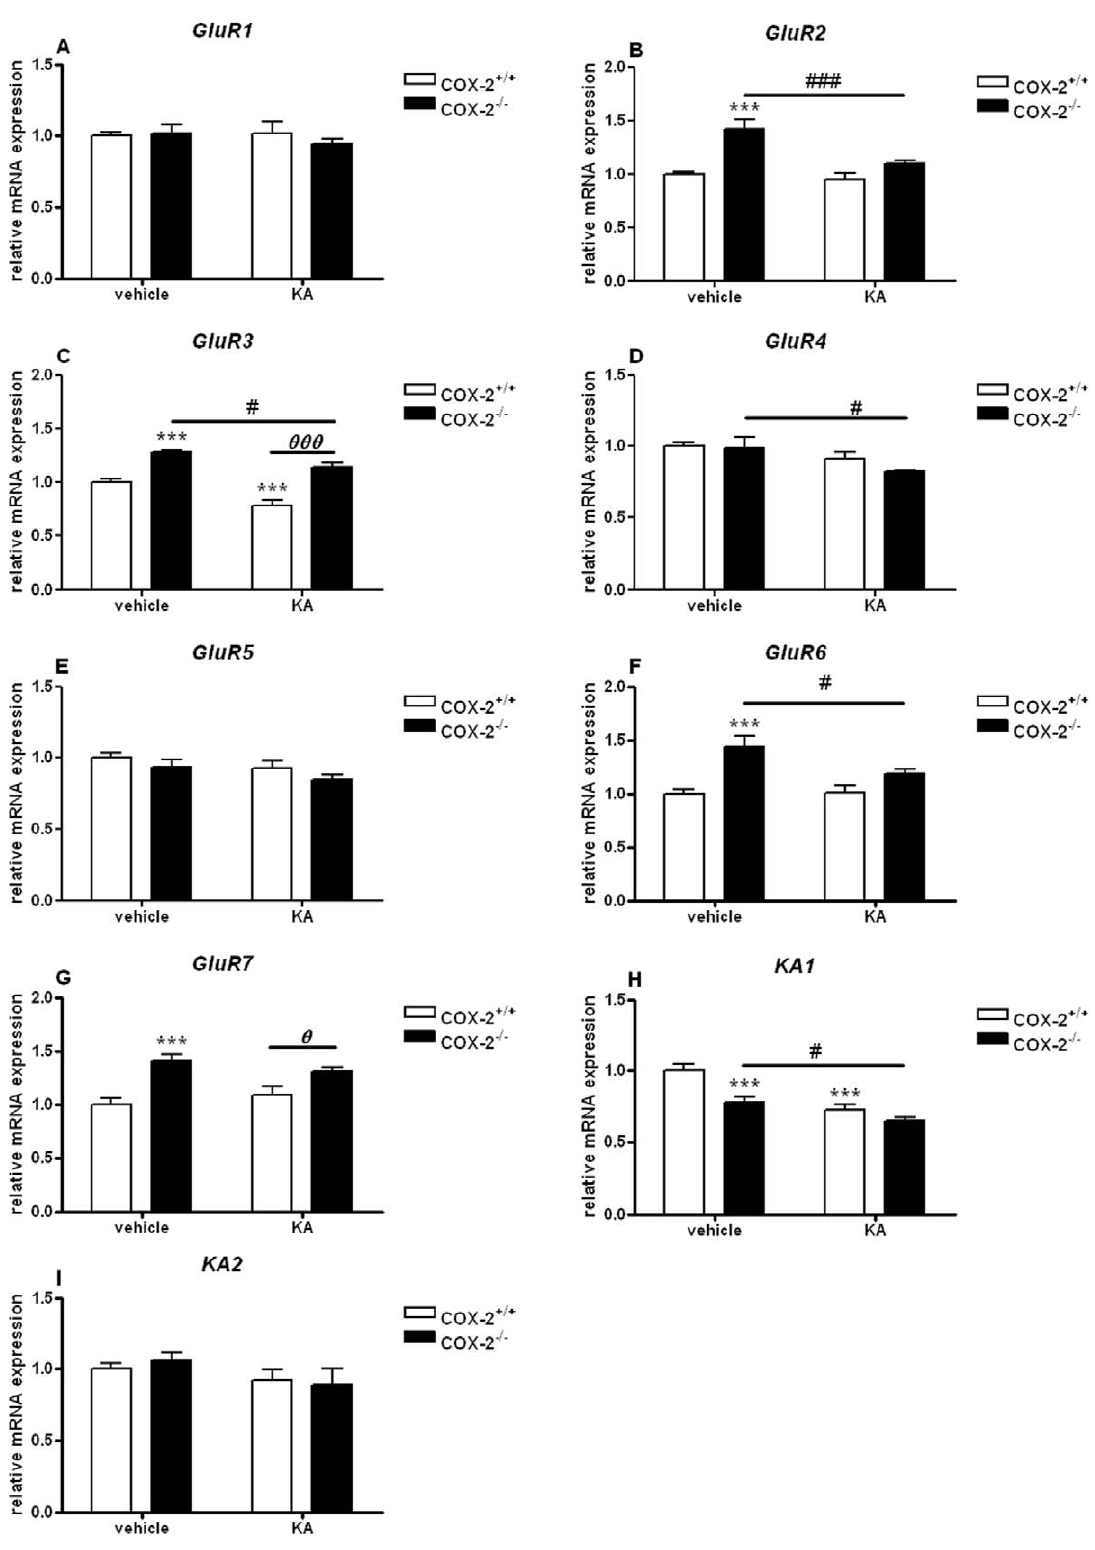
Figure 2. KA-induced expression of AMPA/KA receptor subunits in the cortex of COX-2 + / + and COX-2 2 / 2 mice. Quantitative real time- PCR analysis of GluR1 (A), GluR2 (B), GluR3 (C), GluR4 (D), GluR5 (E), GluR6 (F), GluR7 (G), KA1 (H), KA2 (I) for COX-2 + / + and COX-2 2 / 2 mice 24 h after i.p. injection of KA or vehicle. Data are means 6 SEM ( n =9). Statistical analysis was performed using a two-way ANOVA and Bonferroni’s post-hoc test to compare replicate means. *P , 0.05, **P , 0.01, *** P , 0.001 compared to vehicle-injected COX-2 + / + mice; # P , 0.05, ## P , 0.01, ### P , 0.001, compared to vehicle-injected COX-2 2 / 2 mice; fi P , 0.05, fifi P , 0.01, fififi P , 0.001 between KA-injected COX-2 2 / 2 and KA-injected WT mice. doi:10.1371/journal.pone.0019398.g002 PLoS ONE |